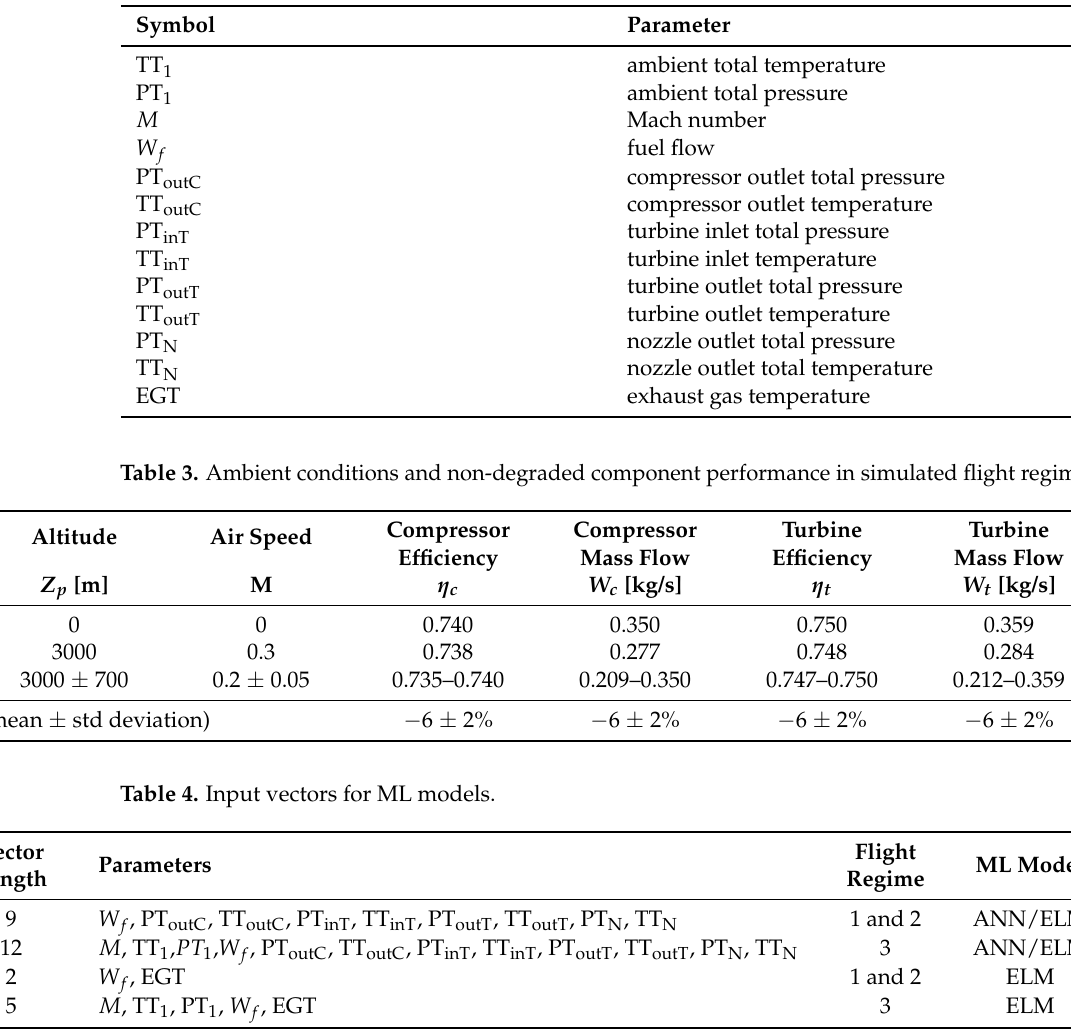
Table 2. Virtual sensors: simulated engine parameters.